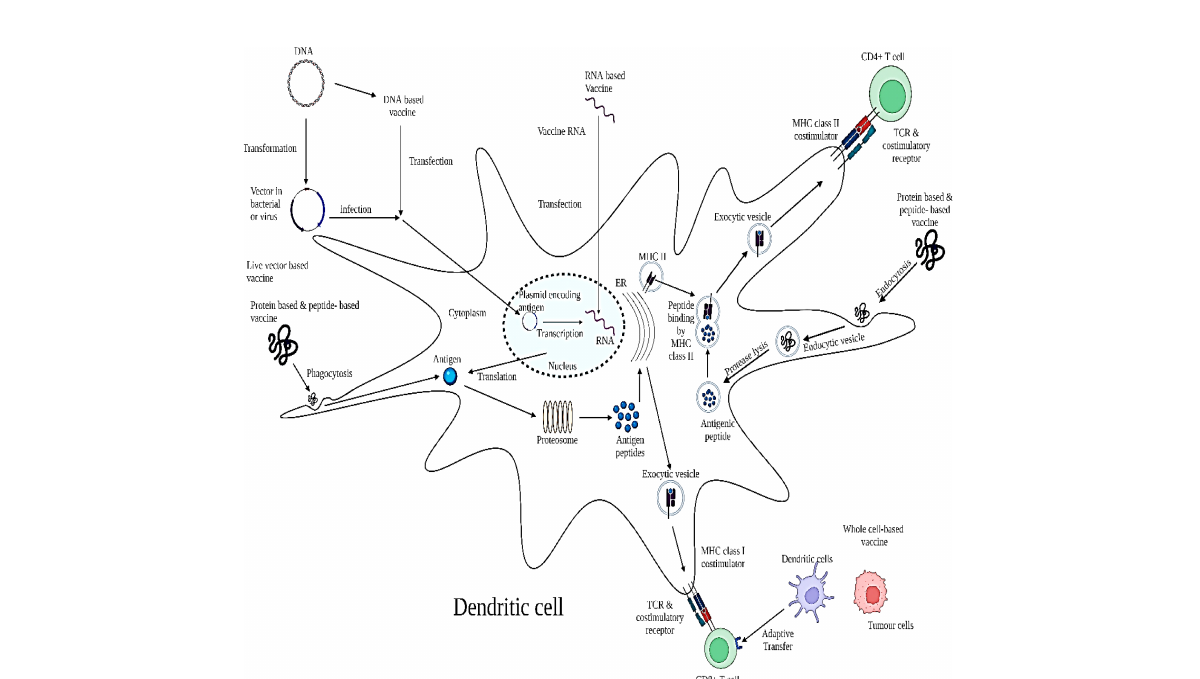
FIGURE 5 Schematic model depicting the mechanism of action of therapeutic vaccine. The mechanism for anti-HPV activity constitutes through its targeting of E6 and E7 oncoproteins upon APCs for activation of CD8+ and CD4+ cells in the TME. Administration of varying therapeutic HPV vaccine types results in the delivery of different forms of antigen into the body. DNA plasmids encoding HPV oncoproteins E6 and E7 can be transfected into dendritic cells through DNA vaccines or infection of transformed live vector-based vaccines. These antigens are then transcribed into RNA; however, RNA can also be introduced into the cell through RNA vaccines. Transcribed RNA is further translated into antigen proteins or long peptides. Antigen proteins or long peptides can also be taken up by the dendritic cell through phagocytosis after administration of a protein-based or peptide-based vaccine. These proteins or peptides are processed into short peptides by proteasomes and loaded onto an MHC class I molecule in the endoplasmic reticulum (ER) to be presented to T-cell receptors on CD8+ T cells. In addition, dendritic cells or tumor cells can be prepared ex vivo to express target antigens on MHC class I molecules with necessary co-stimulatory molecules and be administered back into the body as whole cell-based vaccines through adoptive transfer to prime T cells. On the other hand, the protein or peptide antigens taken up by the dendritic cell can be degraded into smaller fragments by proteases in the endosome. The endosome containing the small antigenic peptides is then fused with the exosome containing the MHC class II molecule, during which the antigenic peptide is loaded onto the MHC class II molecule. The MHC class II – antigenic peptide complex is then transported to the cell surface to be presented to T-cell receptors on CD4+ T cells. Adapted and modi fi ed with open access permission from